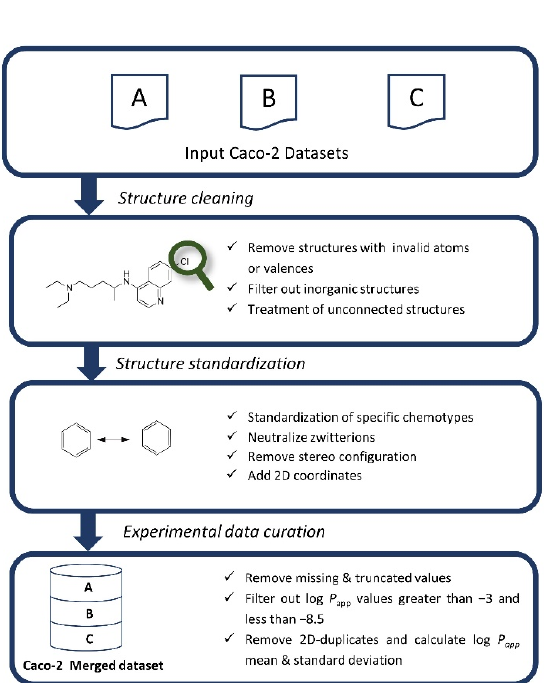
Figure A1. Chemical and experimental data curation workflow. A, B and C in the top corresponds to the three Caco-2 datasets used for constructing the modeling set.